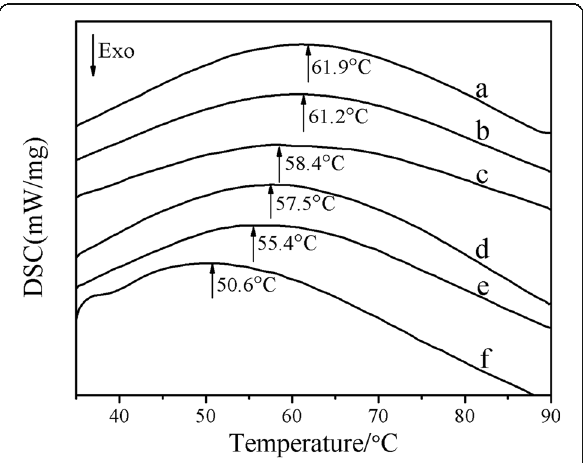
Fig. 1 DCS curves of the insoluble collagen fibers derived from ILs ( a :Col, b :Col/ILs-fibrils70%B, c :Col/ILs-fibrils10%, d :Col/ILs-fibrils30%, e :Col/ILs-fibrils50%, f